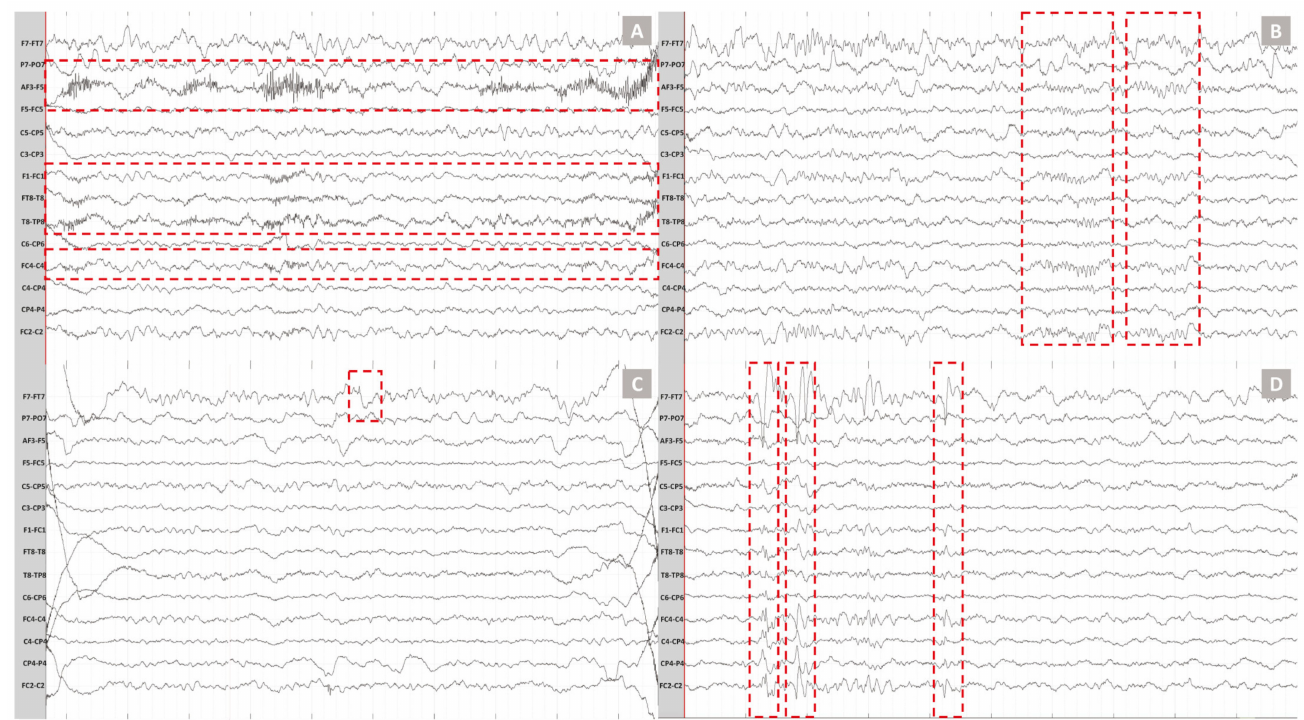
Figure 13. Physiological and pathological signals recorded with the NeoNet EEG system in a 5-year- old patient with epilepsy. The dotted red lines indicate ( A ) the muscle artifact in bilateral temporal extending to the frontocentral leads. ( B ) Sleep spindles at frontocentral leads with their maximum at the FC2-C2 and FC4-C4 leads. ( C ) Eye movement artifact on the left frontal channel. ( D ) Interictal epileptiform discharges with complex field originating from the frontal EEG